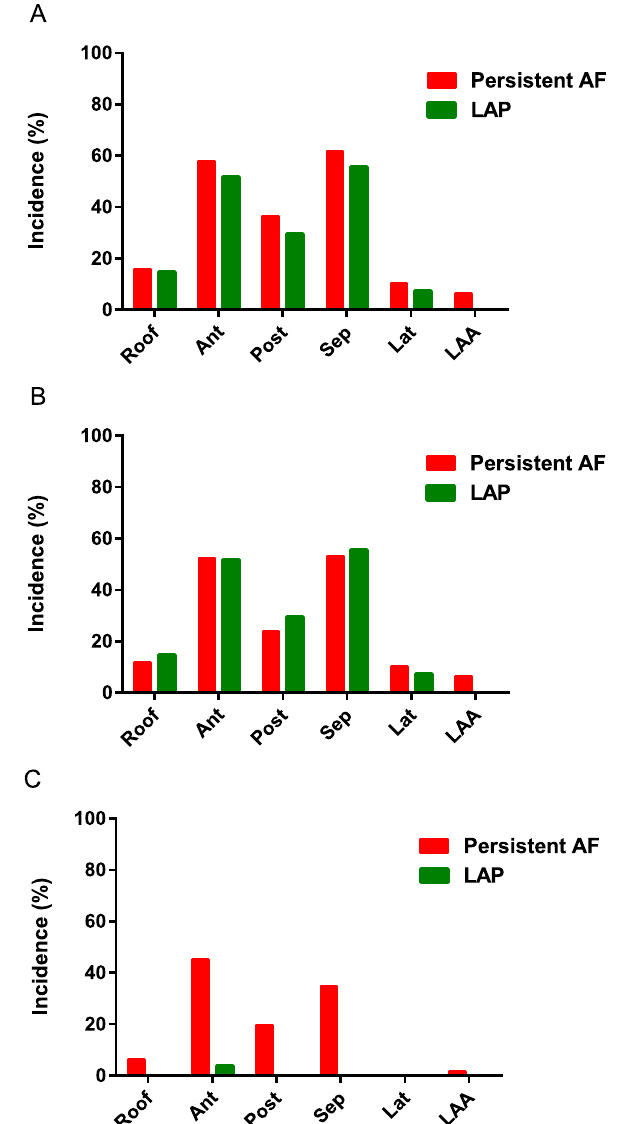
complex electrograms in sinus rhythm; LAP, left-side accessory